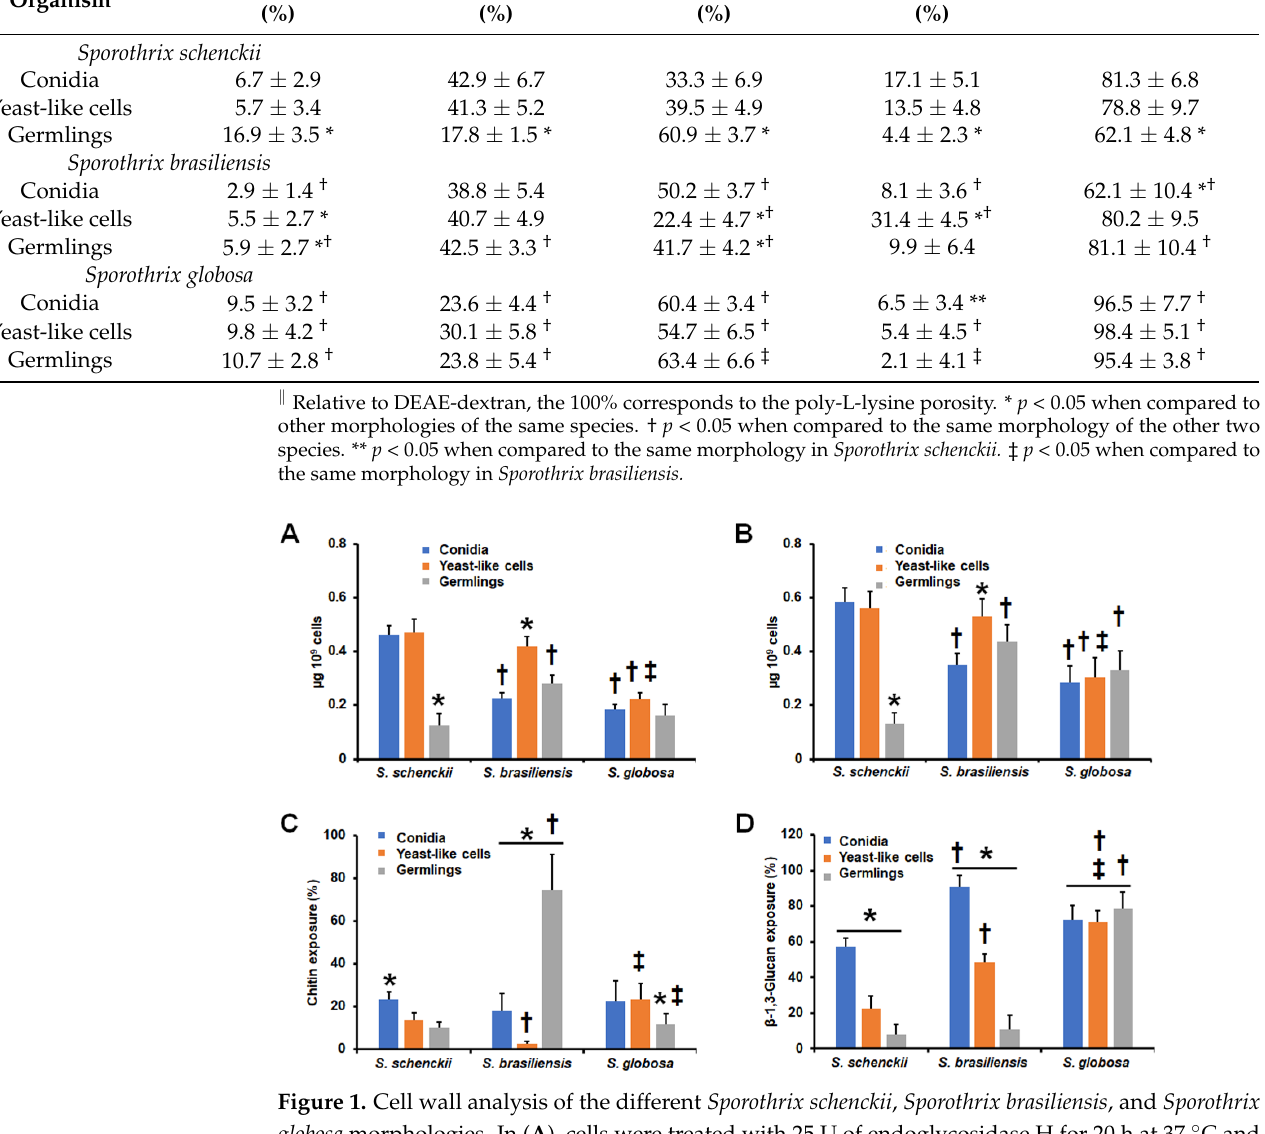
Porosity (%) (cid:107)